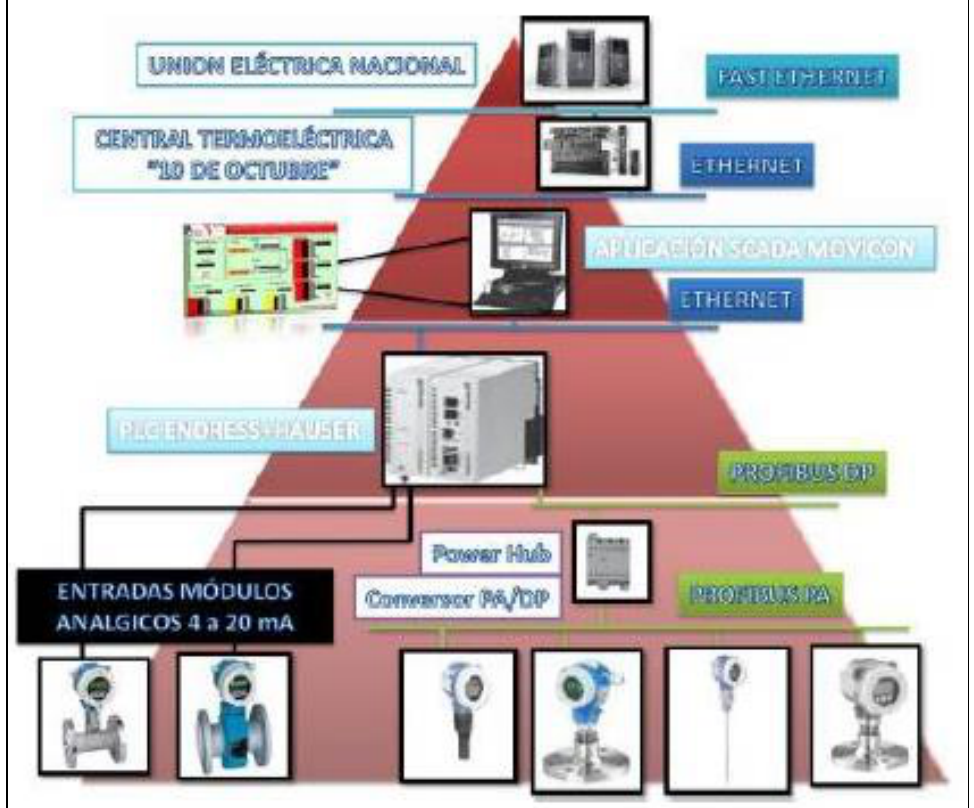
Figura 17. Pirámide de Automatización de un subsistema la planta de tratamento químico de agua. Fuente: Los Autores,